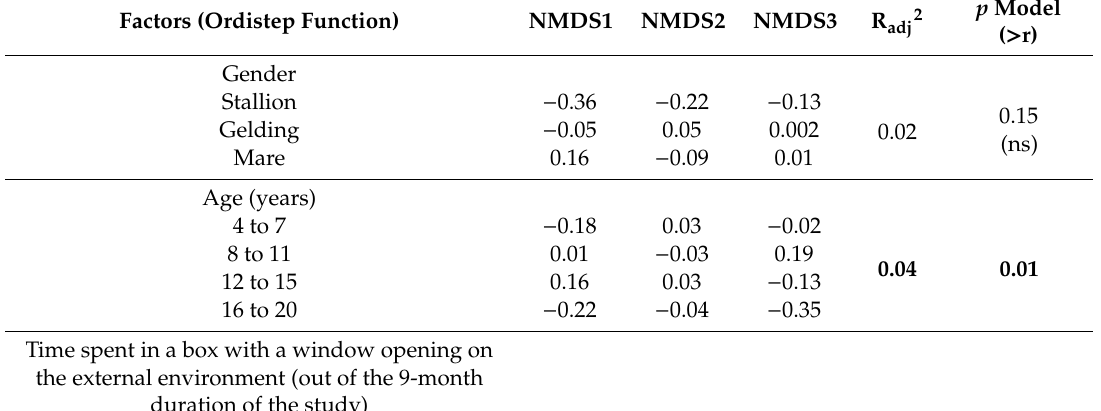
Table 3. The table displays the correlations between the 12 factors studied and the non-metric multidimensional scaling (NMDS) ordination of the behavioural structure via the envfit function. p -values are based on 10,000 permutations. For each factor, the table displays the direction cosines of the vector for each of the three axes, the R adj2 (squared correlation coe ffi cient) of the relationship between the factors and the ordination and the permutation-based p -value. The three dimensions used in the NMDS resulted in a stress value of 0.08. ns: non-significant. Only age was significantly correlated with the behavioural structure, with a level accepted at p ≤ 0.05 (in bold). Factors (Ordistep